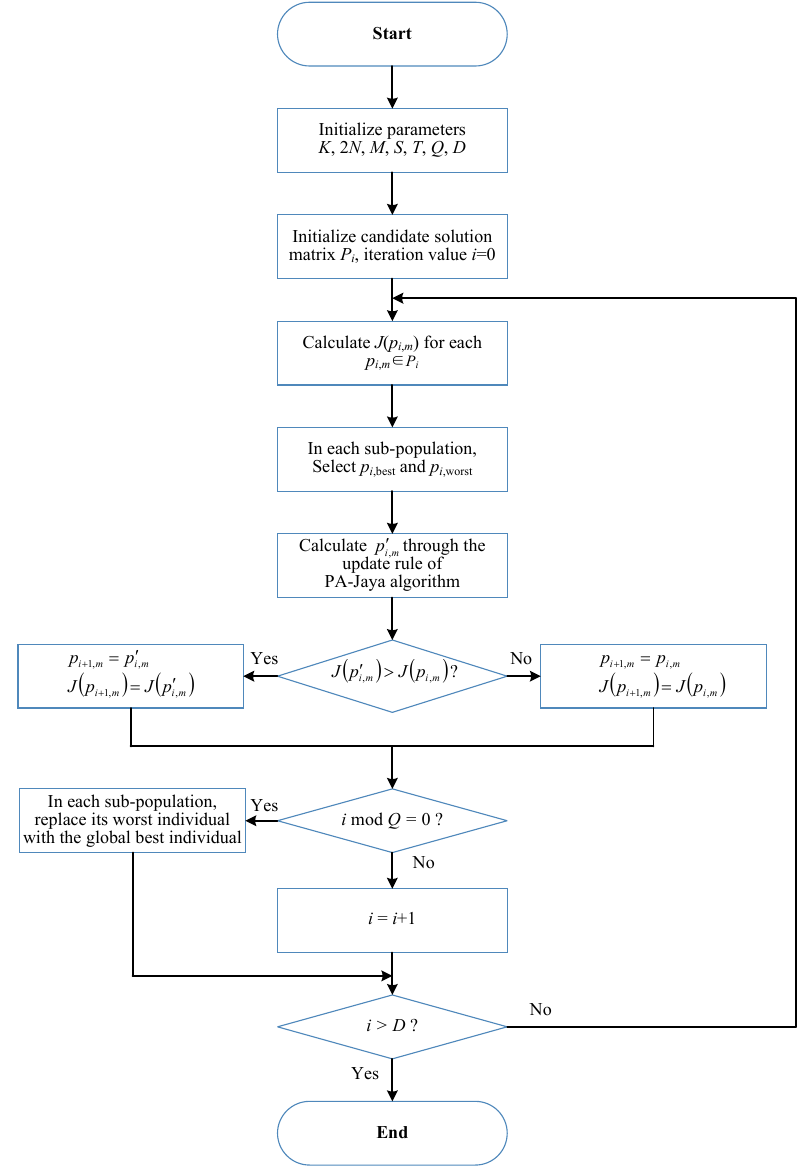
Figure 2. Flowchart of the PA-Jaya algorithm for the cognitive orthogonal frequency division multiplexing (OFDM) radio network power allocation